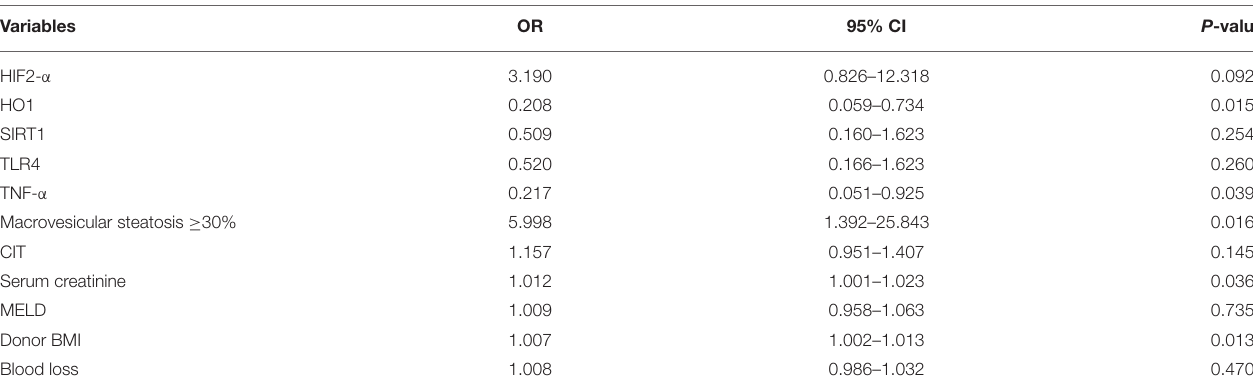
TABLE 3 | Results of multivariate logistic regression analysis of EAD-associated